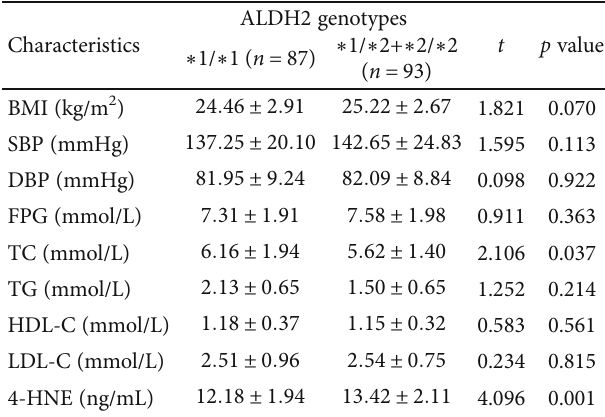
Table 2: Baseline characteristics of ischemic stroke patients with di ff erent ALDH2 genotypes.